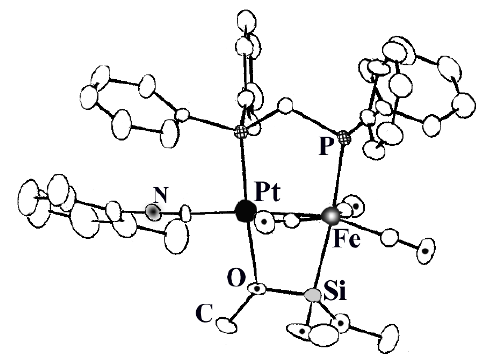
Re( η 1 -4-MeC H N ) 2 6 4 2 }{μ- η 2 - 2